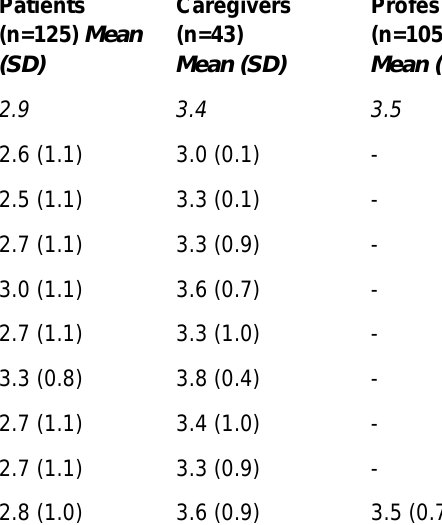
Table 2b. Importance of Requirements for Usability of Stroke e-Rehabilitation According to End Users (n=273)